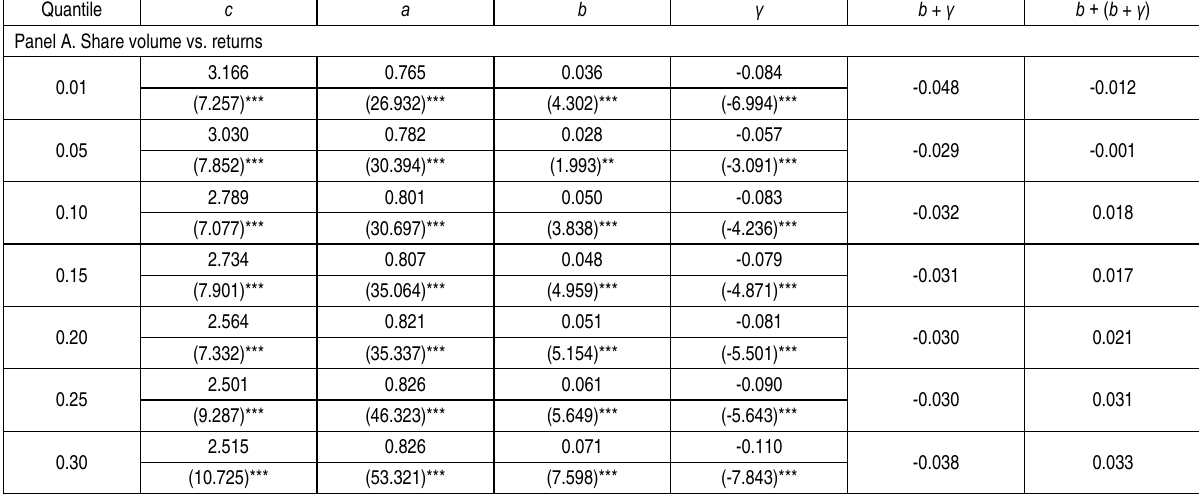
Table 7. Quantile regression estimates of volume-signed return correlation for TAIEX in the partly-eliminated